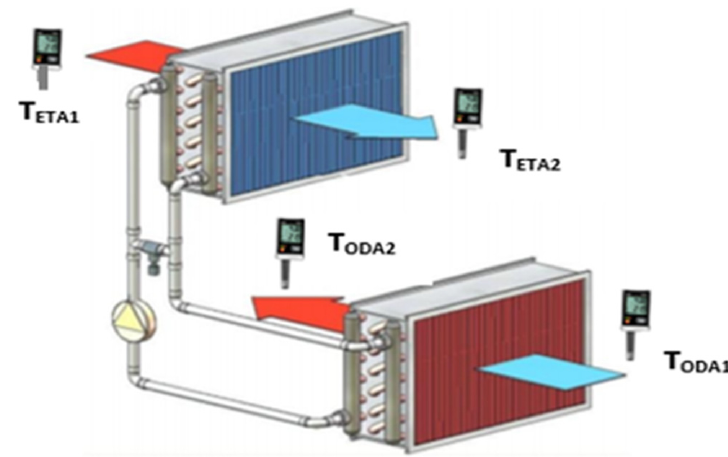
Figure 3. Working Principle of Run-Around Loop Heat Recovery.